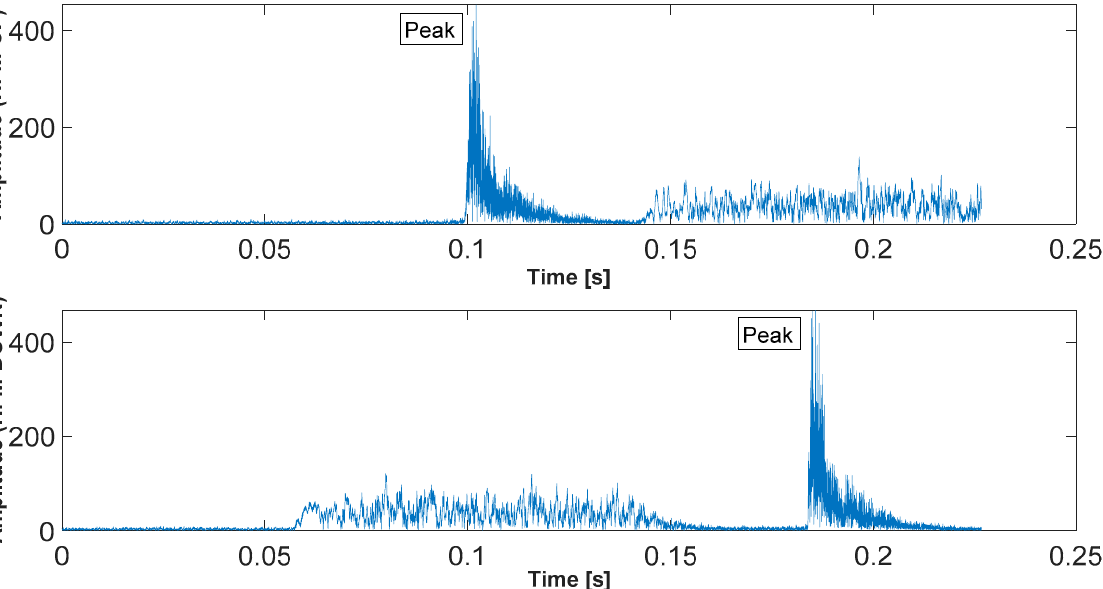
Figure 9. Correlation functions for the signal pair HFM-UP and HFM-DOWN ( T PS = 64 ms).